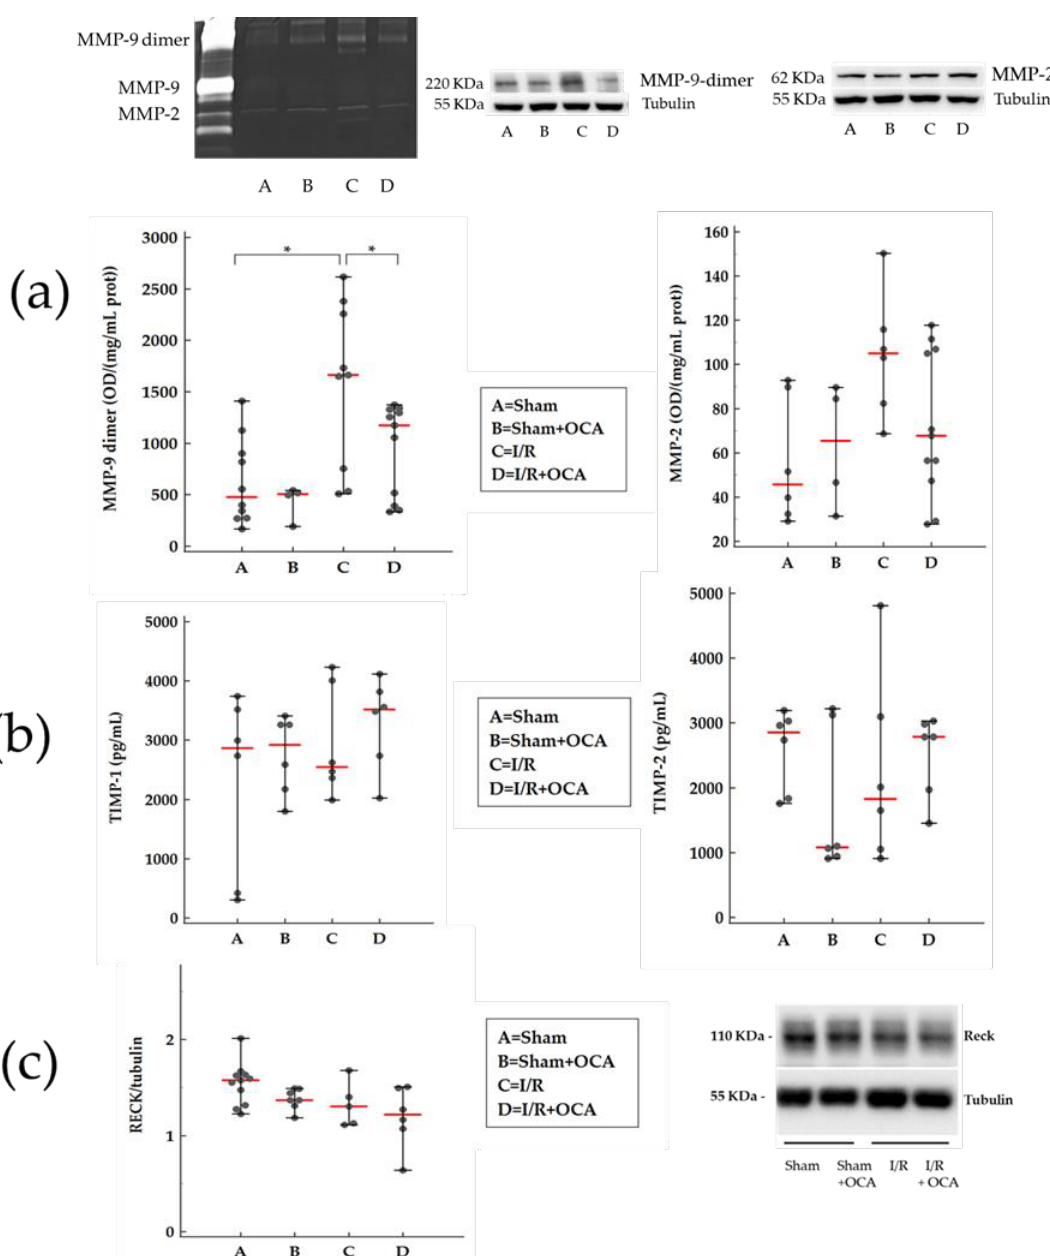
Figure 1. OCA treatment decreases MMP-9-dimer activity in kidney cortex after liver I/R. Animals were orally administered 10 mg/kg/day of OCA in methylcellulose 1% vehicle for 5 days ( n = 12) or vehicle alone ( n = 12). ( a ) Representative of MMP zymography and Western blot; gelatinolytic activities of MMP (MMP-9-dimer and MMP-2) quantified by densitometry. ( b ) TIMPs (TIMP-1 and TIMP-2) by Elisa kits and ( c ) RECK expression levels, by Western Blots, were determined in kidney cortex of rats submitted to partial liver ischemia (60 min) followed by reperfusion (120 min). Sham-operated animals were subjected to the same procedure without clamping the vessels. n = 6 rats/group. Results are expressed as median value (line red) ± error bar (1–99 percentiles) (black dot). One-way ANOVA with Tukey–Kramer test (TIMP-1 and RECK); Kruskal–Wallis test with Conover test (MMP-9-dimer, MMP-2, TIMP-2). * p < 0.05 versus I/R rats.